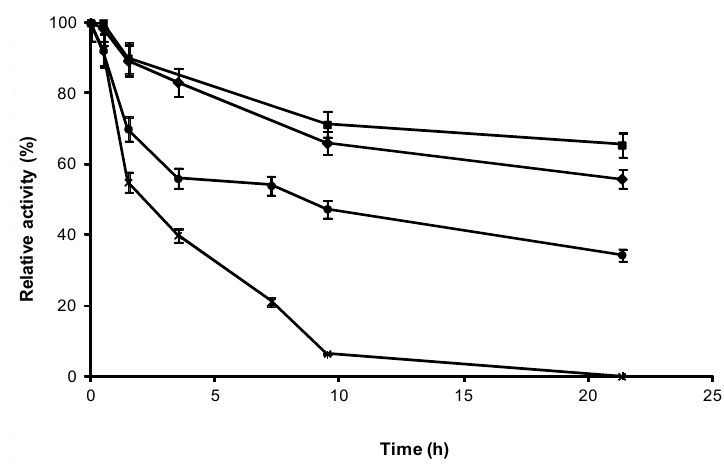
Figure 5. Thermal inactivation course of different CRL immobilized preparations. Experiments were performed at 50 ˝ C and pH 5. Free CRL ( ˆ ), Ald-EDA-CRL (rhombus), Ald-CRL (squares), Ald-Lew105-CRL (circles).